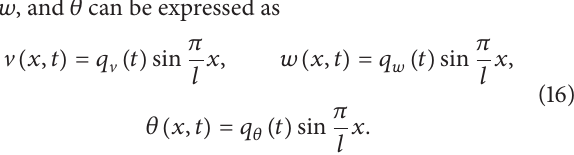
Table 1: Parameter employed in this